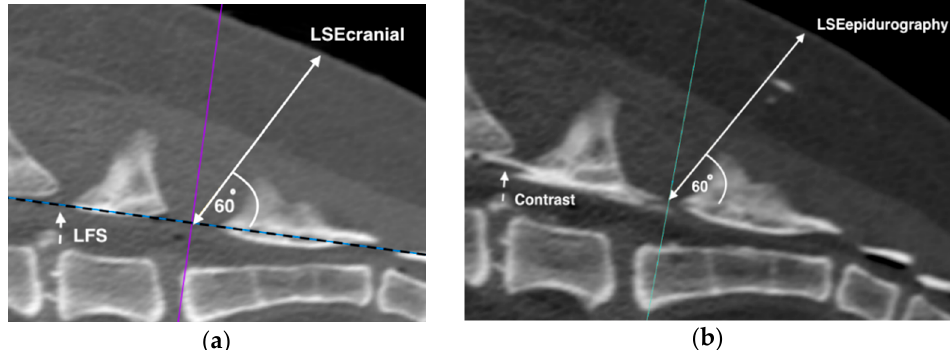
Figure 2. Computed tomography (CT) derived lumbosacral epidural distances (CLED) involving pelvic limbs in cranial extension (LSEcranial ( a )), and contrast epidurography (LSEepidurography ( b )). Bi-directional arrows represent the measured CLED distance at 60 degrees from either the ligamentum flavum surrogate (LFS) (hashed arrow ( a )), or the epidural space confirmed by contrast epidurography (hashed arrow ( b )).